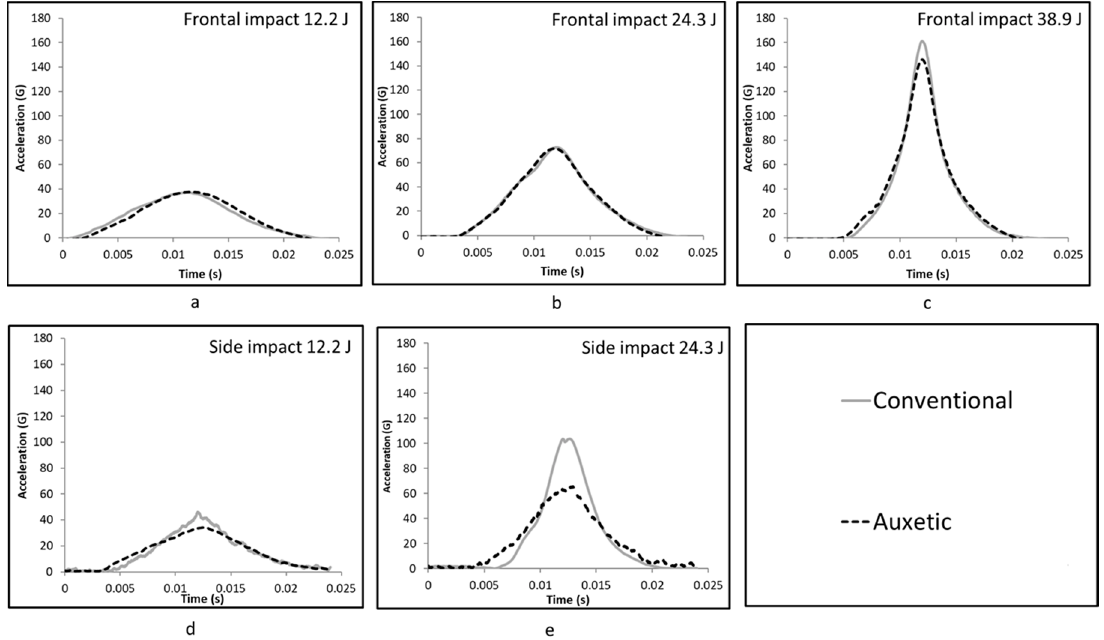
Figure 4. Acceleration traces for the conventional and auxetic foam inserts in the frontal impacts at ( a ) low (12.2 J), ( b ) medium (24.3 J), and ( c ) high (38.9 J) energies and for side impacts at ( d ) low (12.2 J) and ( e ) medium (24.3 J) energies.